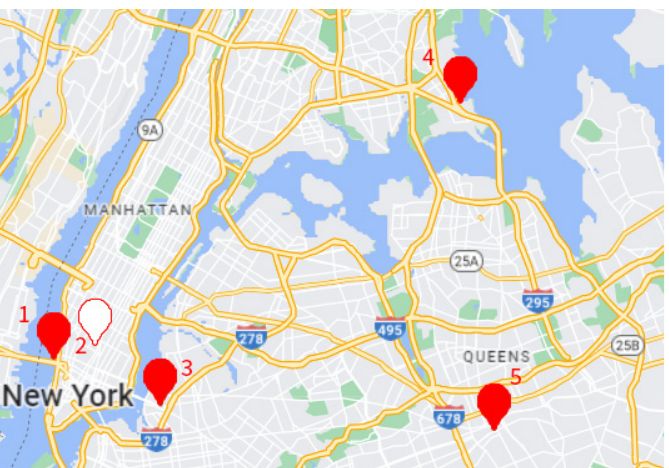
Figure 6. The sample map shows a sequence of locations that our model outputs. By examining the exact location in the Google Map, we found that location 2 is the New York Academy of Photography, other locations are very suitable for photography, for example, locations 1, 3, and 4 are parks, and location 5 is a Fine Arts Gallery. Although these locations are not adjacent to each other on the map, our model exploits the correlation between these